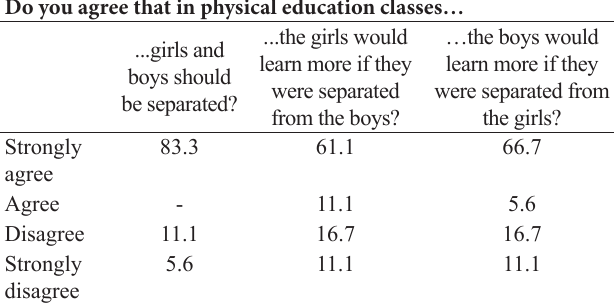
Table 6. Percentage of teacher’s degree of agreement with statements about the improvement of students’ learning in physical